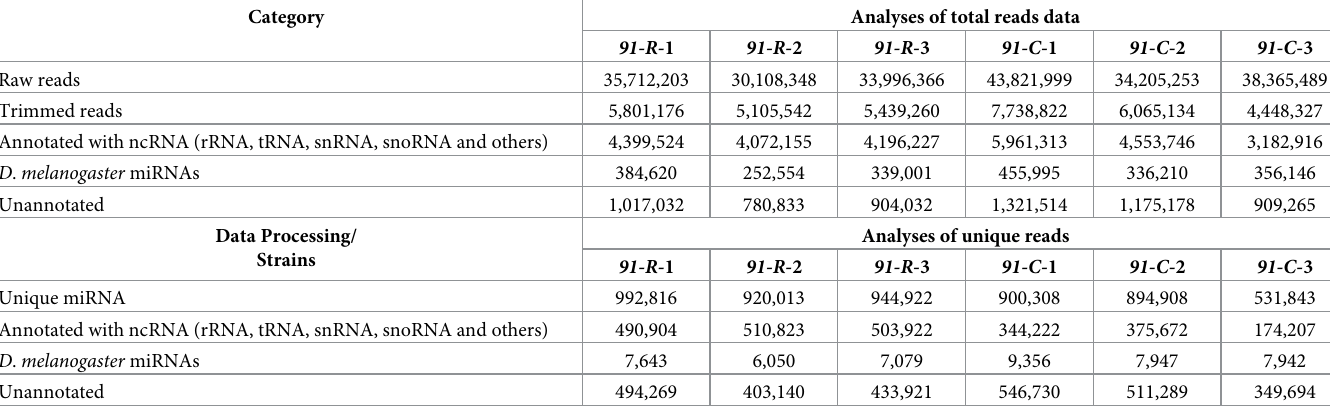
Table 1. Small RNA sequences from 91-C and 91-R triplicate libraries read